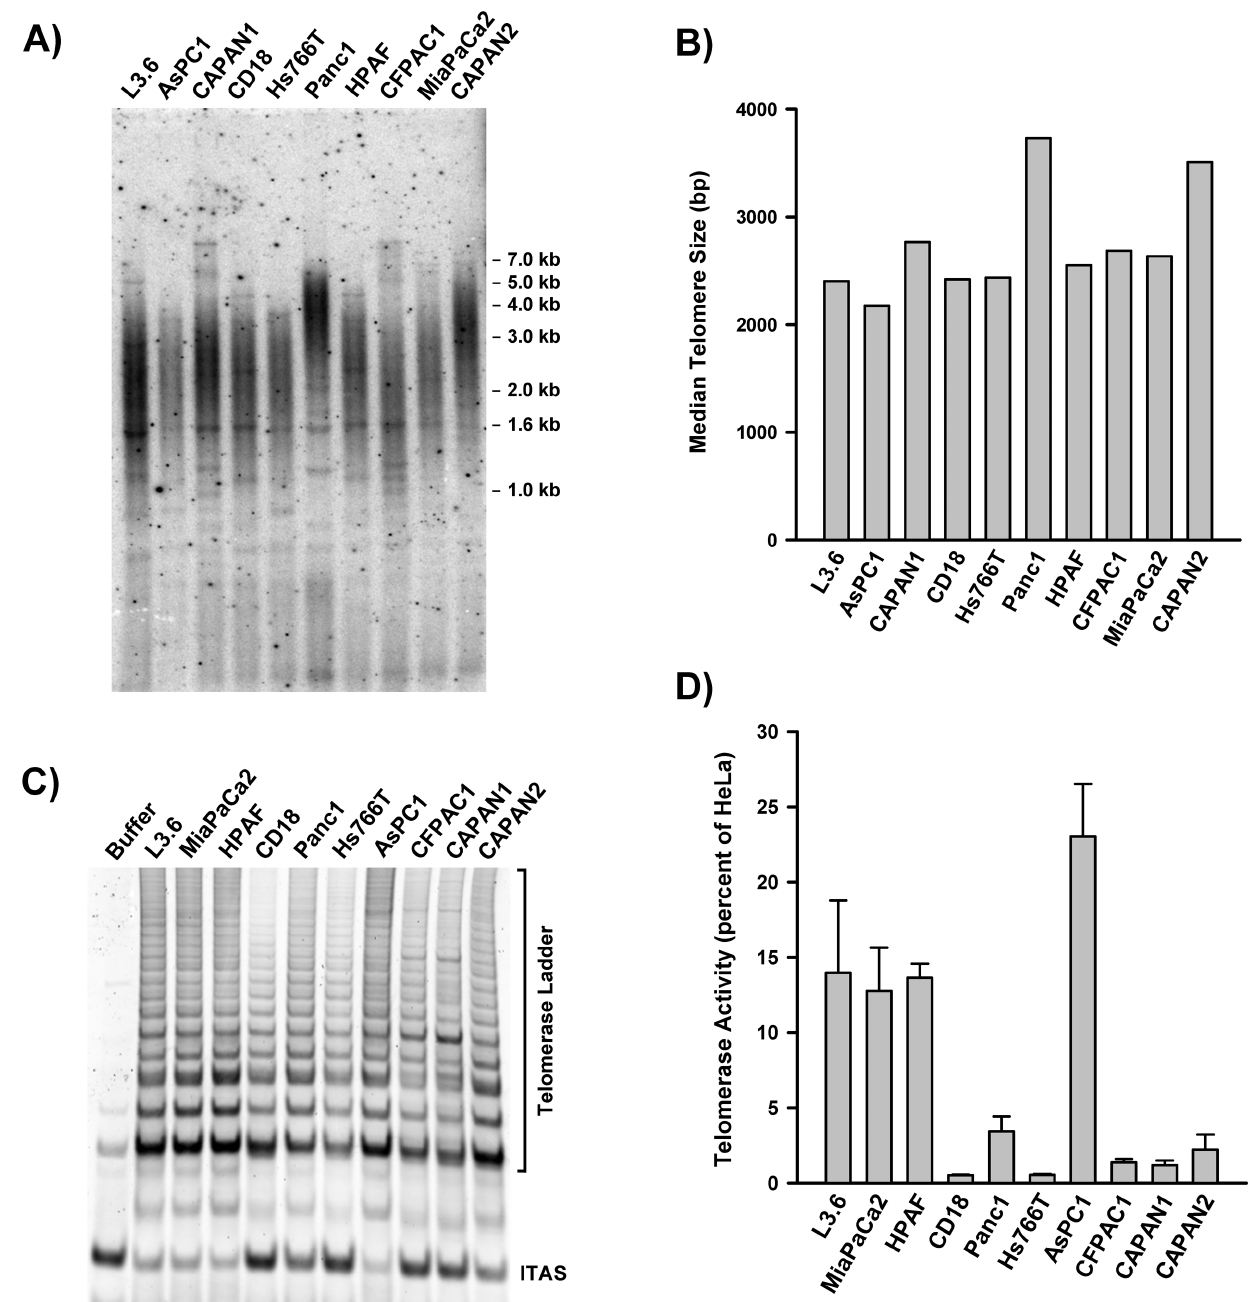
Figure 1. Telomere size and telomerase activity among pancreatic cancer cell lines. A) Telomere size measurements. Genomic DNA was digested with restriction enzymes, resolved by electrophoresis in agarose gels and detected by in situ hybridization to [ 32 P]-(CCCTAA) 4 . B) Quantification of telomere size. Gel in A was scanned and the intensity of each lane was plotted as a function of telomere size, as described in the Material and Methods section. The median telomere size was estimated as the size corresponding to half the cumulative sum of the intensities. C) Detection of telomerase activity by the TRAP assay. Cell extracts containing 300 cells each were assayed using a Cy5-labeled TS oligo substrate. After PCR with the same oligo and a telomeric comeback primer, products were resolved by electrophoresis and detected with a Typhon PhosphoImager. Buffer was lysis buffer only. ITAS, Internal Telomerase Assay Standard. D) Quantification of relative telomerase activity. Relative telomerase activity was calculated as the ratio of the intensity of the telomerase ladder over the intensity of the ITAS. Each measurement is the Mean 6 S.D. of triplicate samples (n=3). Telomerase activity in each line is expressed as a percent of HeLa cells’ activity. doi:10.1371/journal.pone.0085155.g001 CFPAC1 and MiaPaCa2 (IC 50 = 52 nM, both). We saw no of the cell lines to GRN163L, as measured by their respective IC 50 correlation between baseline telomerase activity and the response (Figure S1B).